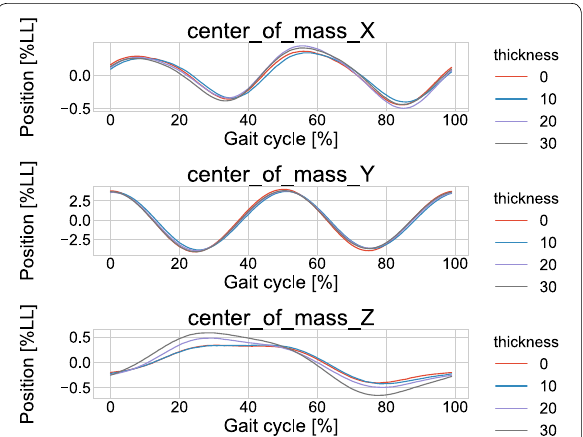
Fig. 12 The CoM position during running. The CoM position on x-axis and z-axis were band-pass filtered (1.0–6.0 Hz). The zero position on x-axis and z-axis does not represent the center of body, but means of position during running